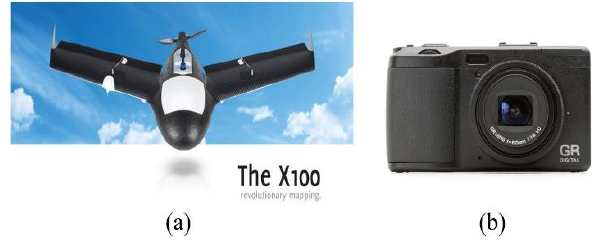
Figure 2. GateWing X100 UAS (URL-4) (a) and RICOH GR DIGITAL IV digital camera (URL-5) (b)